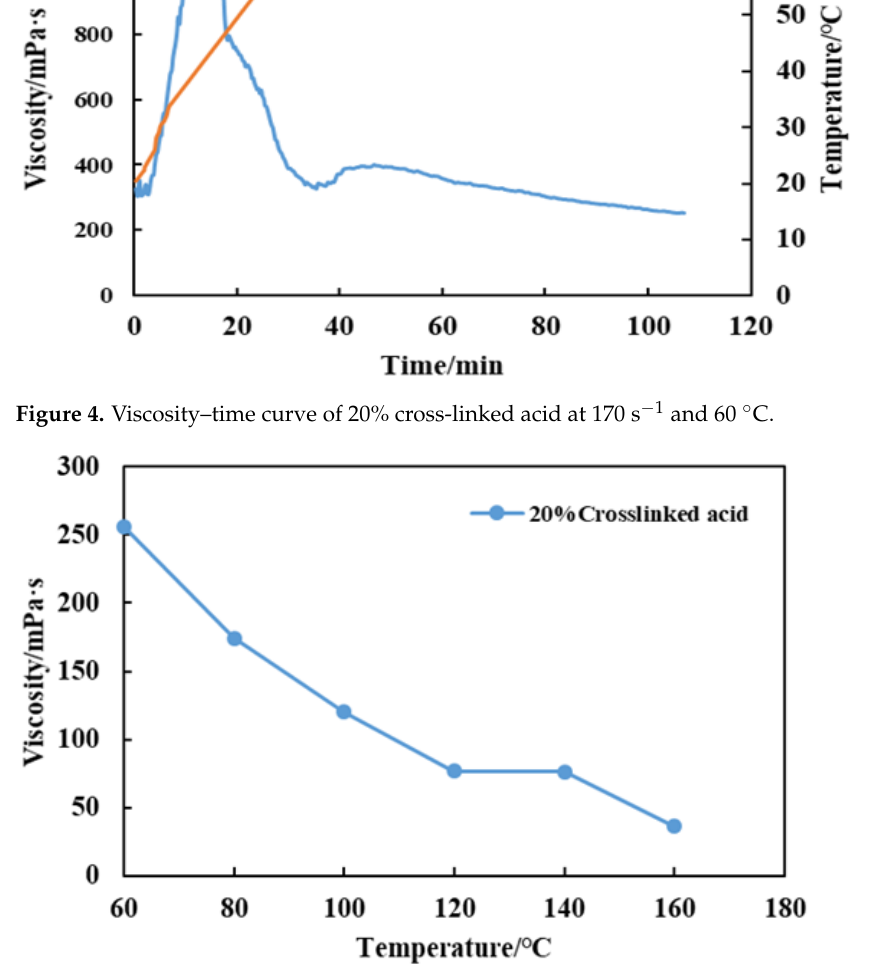
Figure 5. Viscosity test results of 20% cross-linked acid at different temperatures.